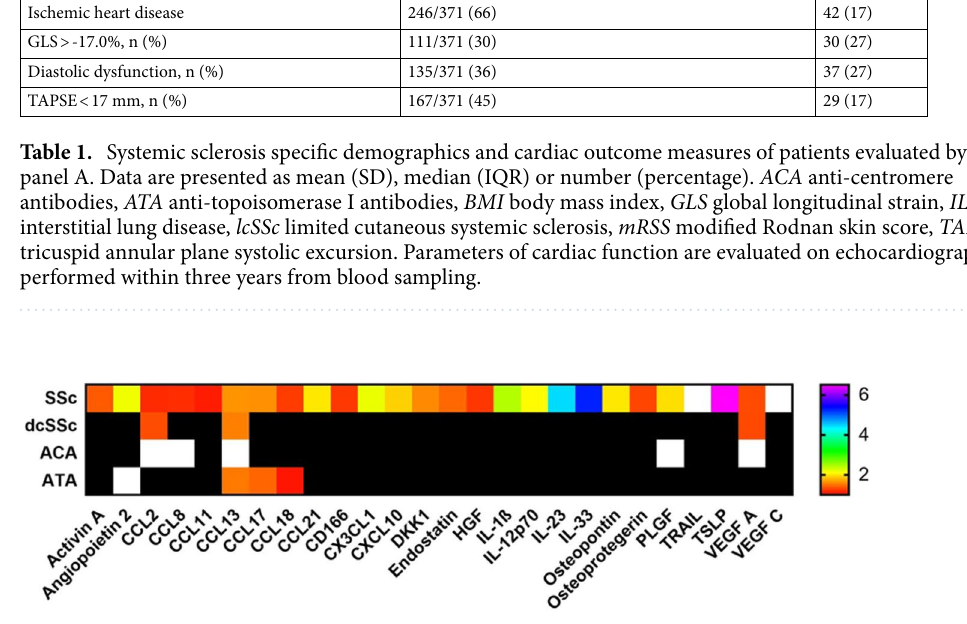
Figure 1. Heat map on circulating serum markers in SSc, diffuse SSc subset and SSc specific autoantibodies (Color print necessary). Mean serum marker values of the SSc group compared to healthy controls and reported as color ratios. Subsets are compared within the SSc cohort; dcSSc is compared to lcSSc, while ACA and ATA positive subsets are compared to ACA and ATA negative subsets, respectively. Colors reflect upregulated serum marker ratios, white squares indicate downregulation, and black squares indicate no significant alteration. ACA anti-centromere antibodies, ATA anti-topoisomerase-I antibodies, CCL C–C motif ligand, CD cluster of differentiation, CXCL C-X-C motif ligand, dcSSc diffuse cutaneous systemic sclerosis, DKK1 Dickkopf-related protein 1, HGF hepatocyte growth factor, IL interleukin, PLGF placental growth factor, SSc systemic sclerosis, TRAIL tumor necrosis factor-related apoptosis-inducing ligand, TSLP thymic stromal lymphopoietin, VEGF vascular endothelial growth